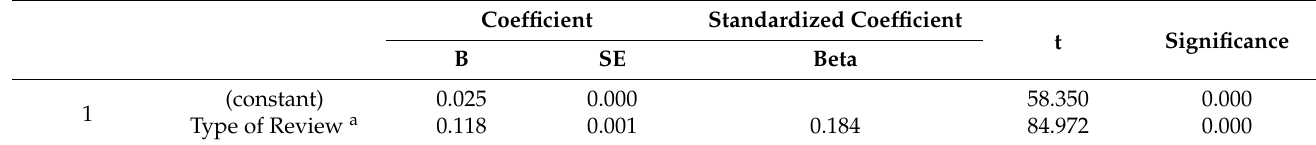
Table 7. Result of Test 1.